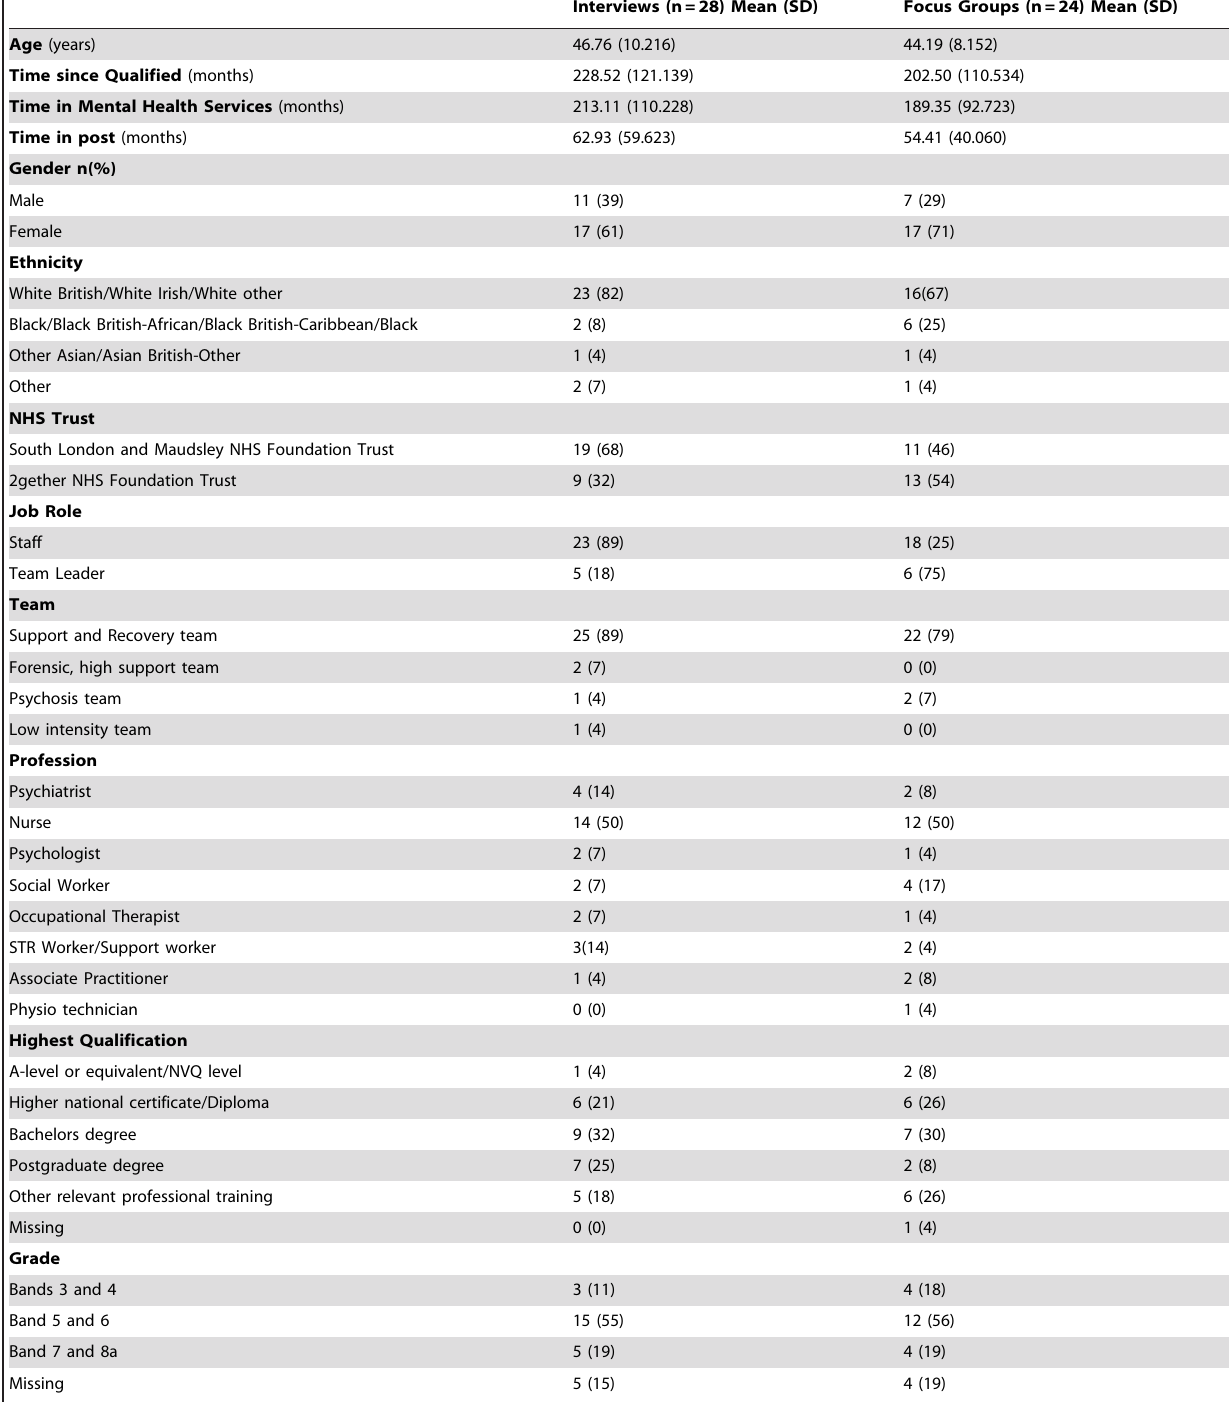
Table 3. Characteristics of staff